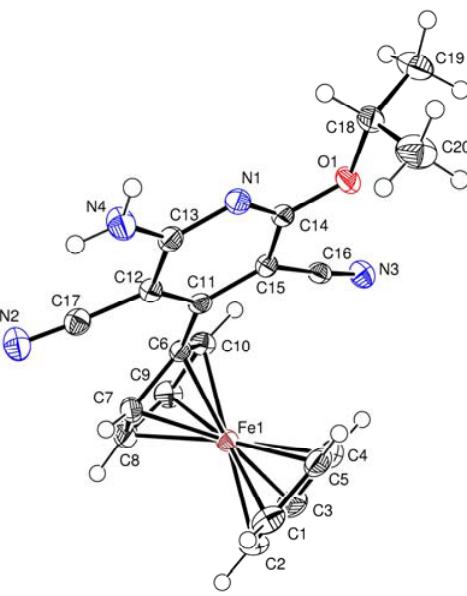
Figure 1. Crystal structure of 3b